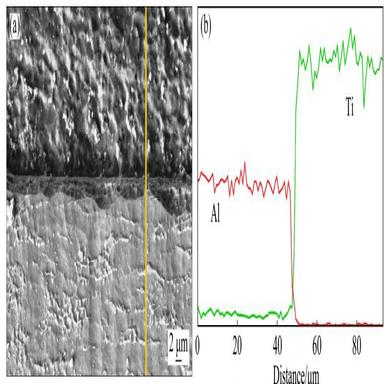
ESEM micrograph of interface at 1000 r/min (yellow line indicates EDS position) (a) and EDS pattern across interface (b)